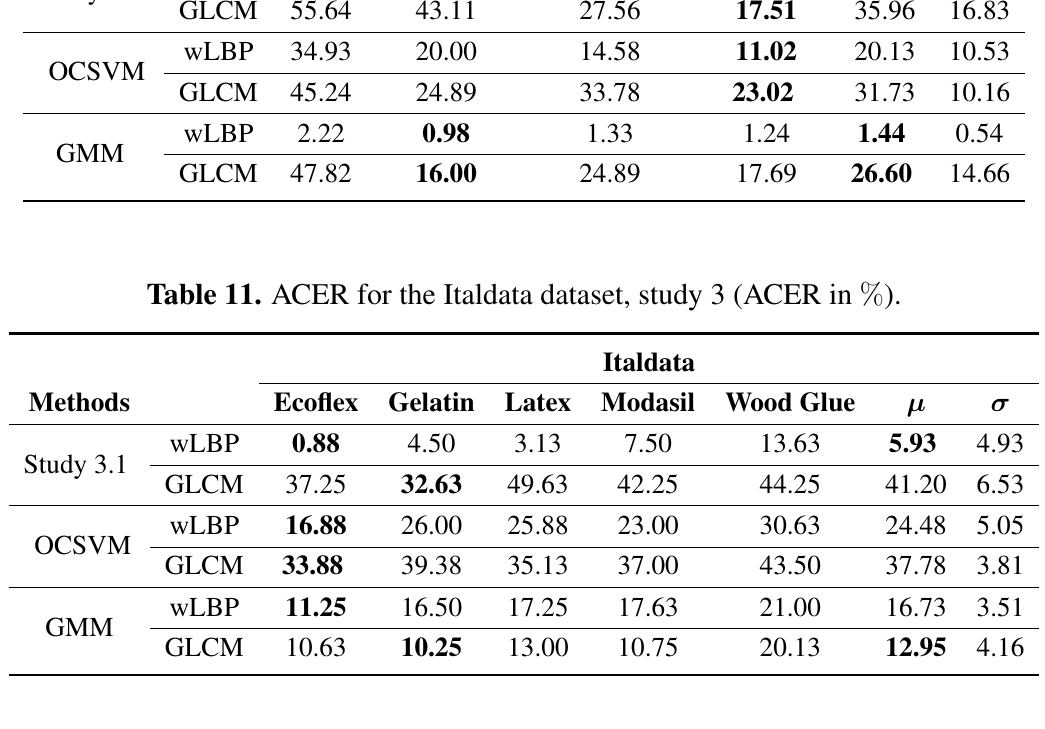
Table 12. ACER for the Swipe dataset, study 3 (ACER in % ).